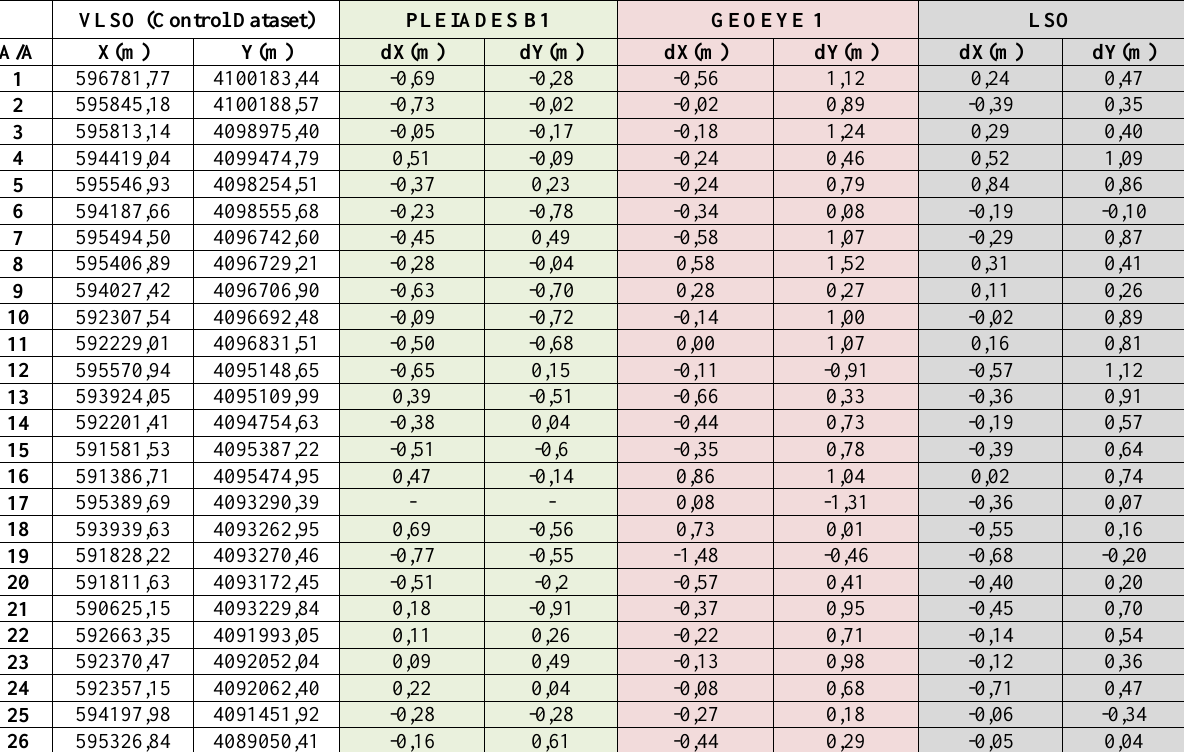
Table 1. Measured coordinates for GeoEye-1 and Pleiades 1B